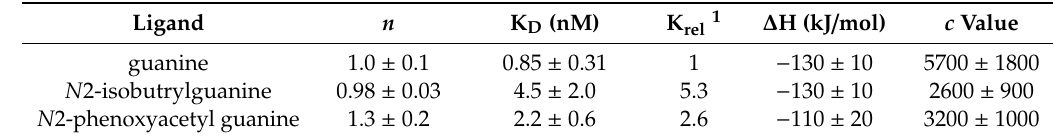
Table 3. ITC measurements of ligand binding to